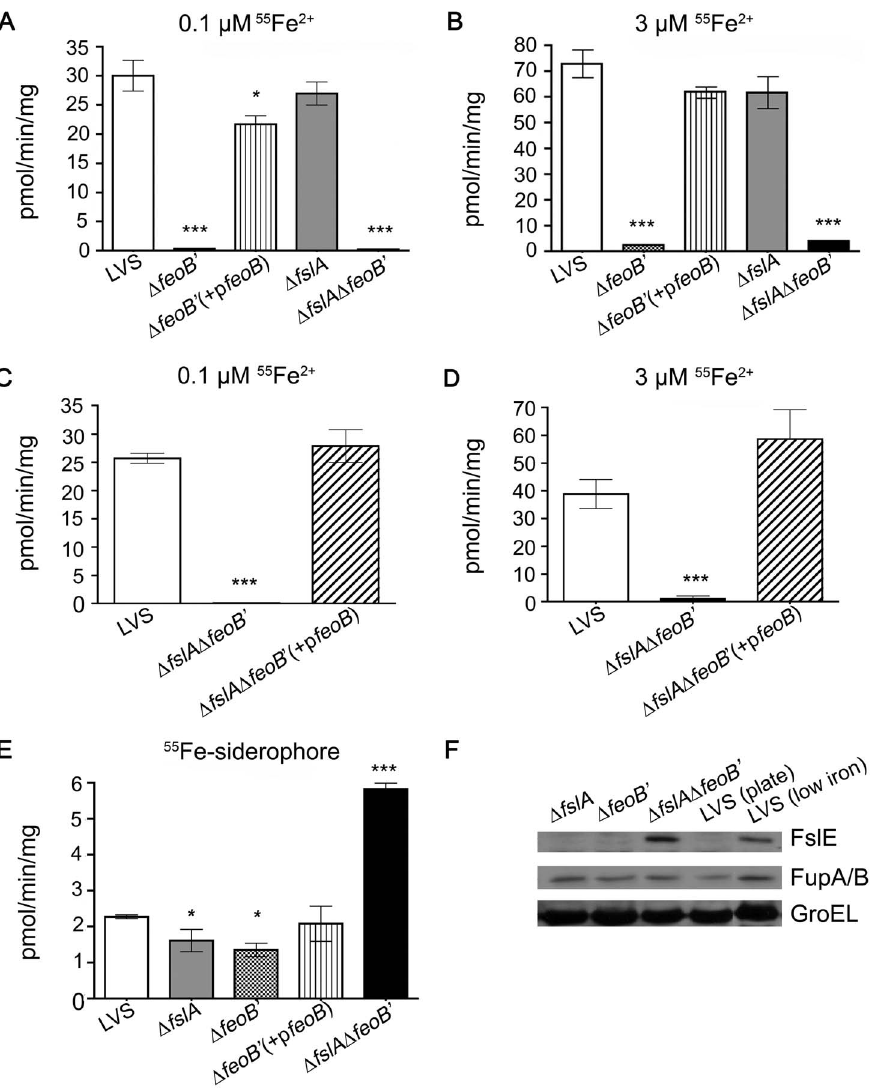
Figure 3. Iron acquisition by LVS single and double mutants and complementing strains. LVS, the D fslA and D feoB 9 mutants and in cis complements as indicated were grown overnight on fresh MHA + plates (with additional siderophore supplementation to the D fslA D feoB 9 mutant) at 37 u C and further inoculated into che-CDM without FePPi for three hours with shaking. Single mutants and the D feoB 9 complement were assessed in A and B, and the complement of the double deletion mutant was tested in C and D. The rate of 55 Fe uptake was determined at (A,C) 0.1 and (B,D) 3 m M [ 55 Fe 2 + ] in the presence of ascorbate. E, Strains were incubated with 55 Fe bound siderophore and rate of 55 Fe uptake was determined. F, Western blotting to determine expression levels of FslE, FupA/B, and the loading control GroEL in bacteria grown on MHA + plates in comparison to LVS grown under iron-limiting conditions. In A–E, values are expressed as the means 6 S.D. Significance was calculated relative to LVS values. * p , 0.05, ***p ,